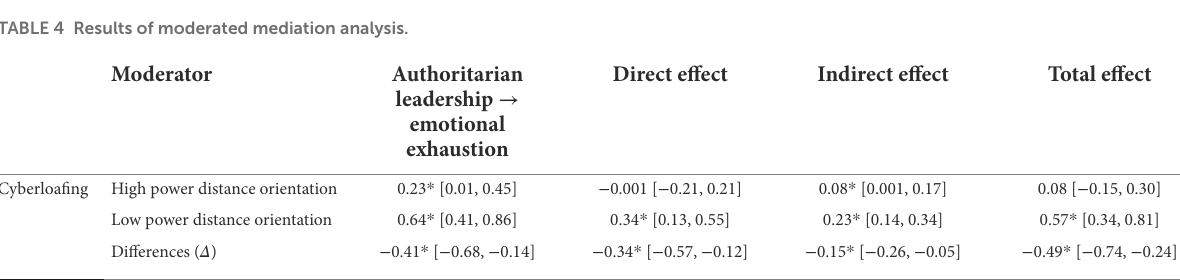
TABLE 4 Results of moderated mediation